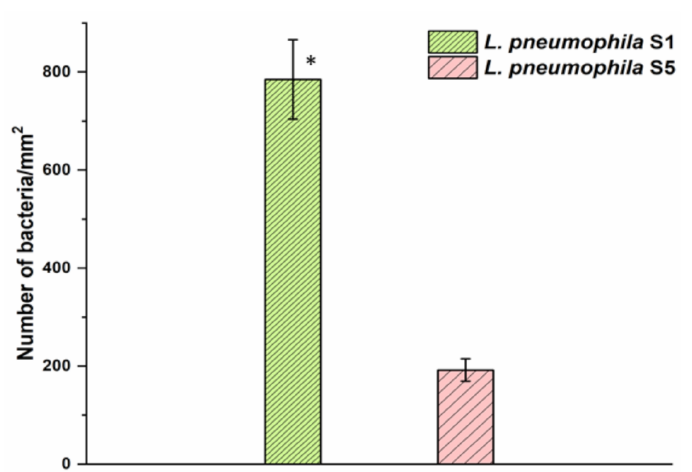
Figure 3. The capture efficiency of L. pneumophila SG1 and SG5 with pAb-functionalized GaAs surface. Error bars represent standard error of the mean from three separate experiments. The asterisk indicates significantly different values compared to the reference as determined by the Student’s test (n = 3, p <